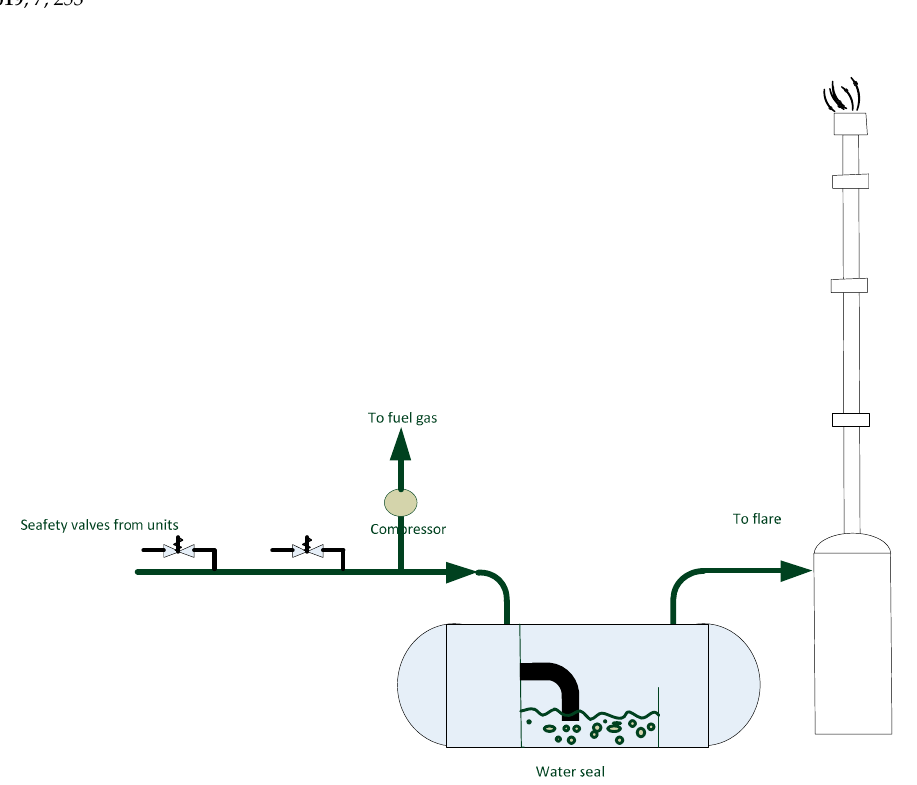
Figure 4. Diagram of the installation recovering the discharge gases, which are “recycled” to the internal heating gas network of the production plant.